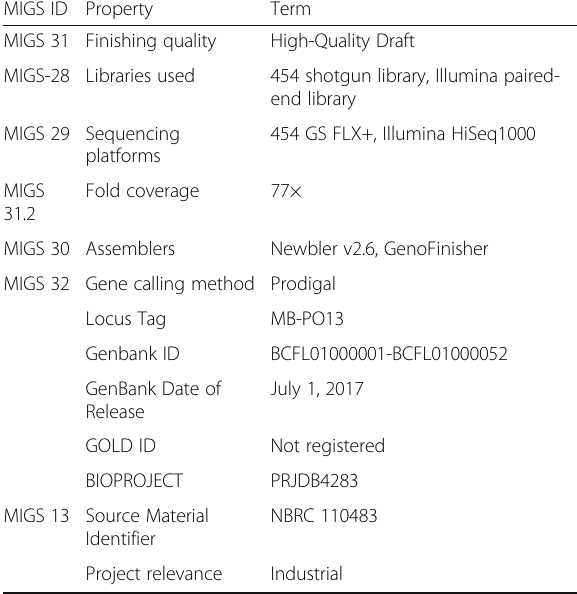
Table 2 Project information